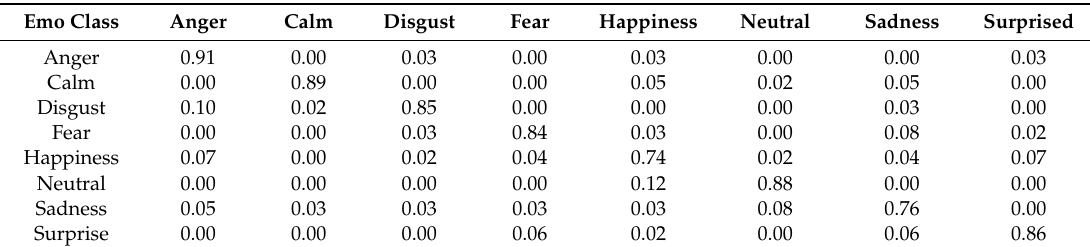
Table 7. Confusion matrix for emotion prediction on RAVDESS using RAVDESS and TESS.